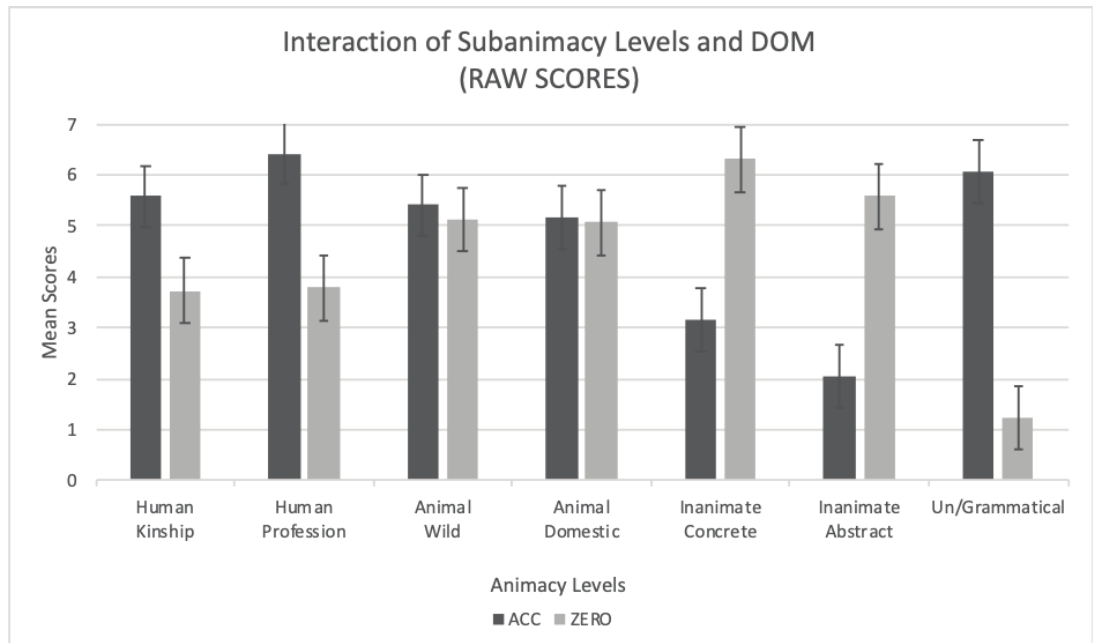
Figure A1. The acceptability of sentences with and without DOM on direct objects that denote entities with varying animacy levels based on raw scores. Error bars represent +/- 2 standard errors